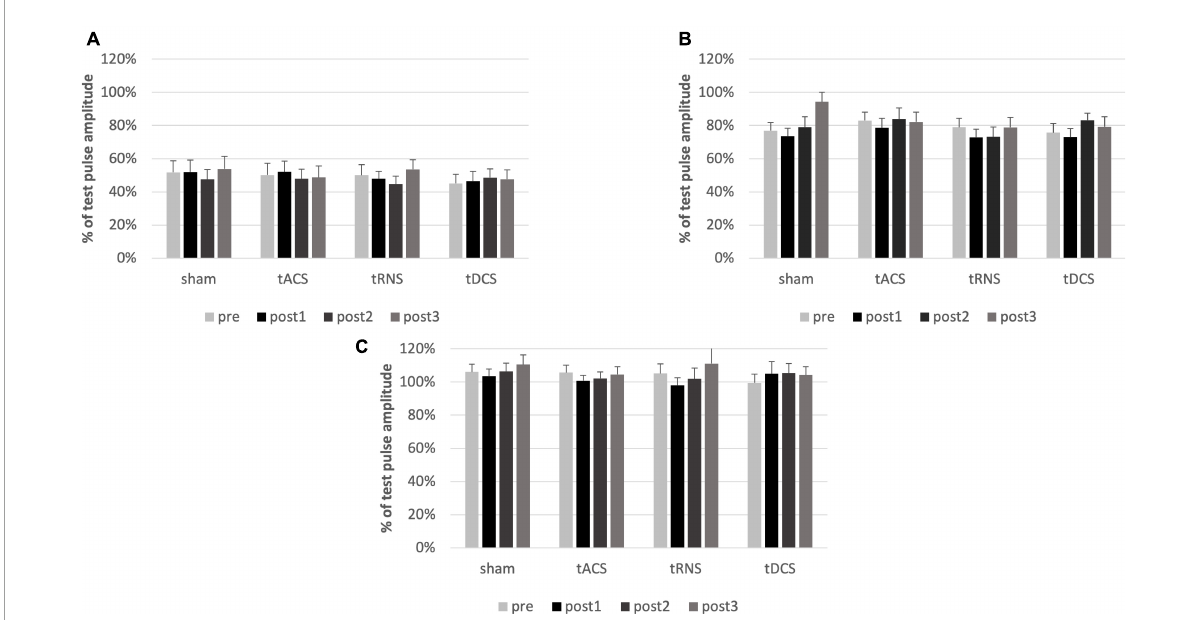
FIGURE3 Analysis of SICI, SAI and CBI. Conditioned MEPs relative to the test pulses pre and post interventions are shown. Error bars representing the standard error of the mean. There is no effect of any cerebellar intervention on SICI (A) , SAI (B) or CBI (C) . SICI results in an inhibition of about 50%, SAI of about 20%. CBI does not influence the MEP. MEP, motor evoked potential; SAI, short-latency afferent inhibition; SICI, short-latency intracortical inhibition; CBI, cerebellar brain inhibition. post1 = 15 min; post2 = 55 min; post3 = 95 min post